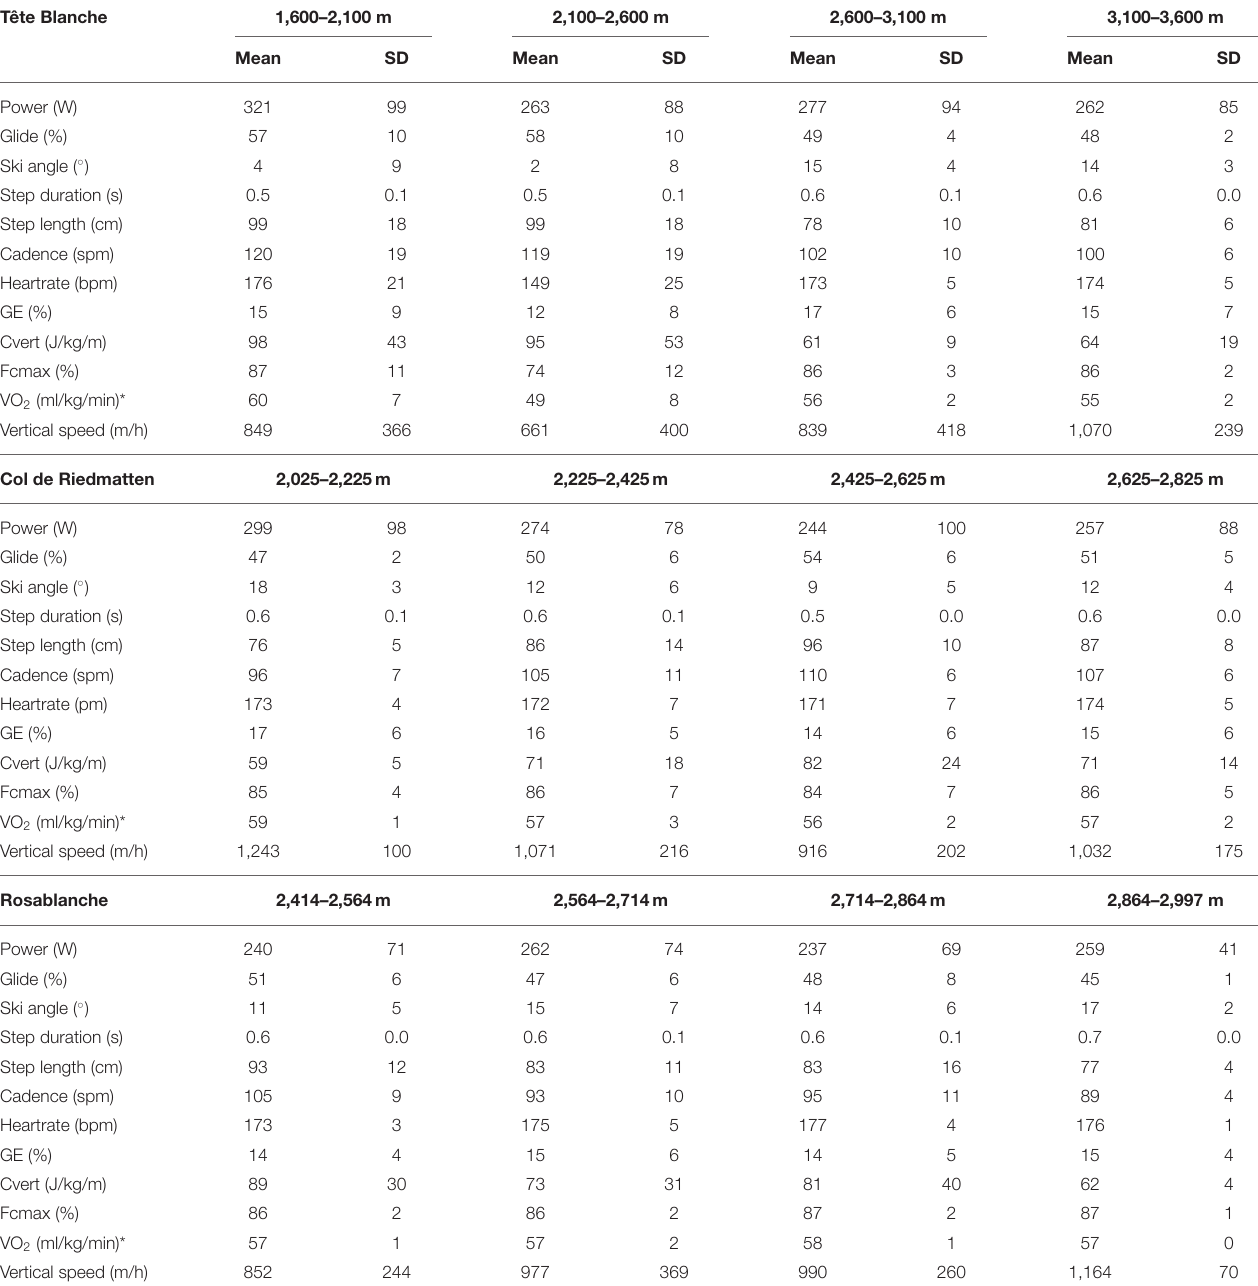
TABLE 3 | Detailed results for athlete #1 during the three main climbs. Tête